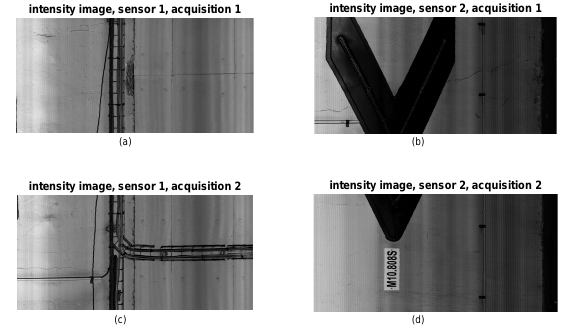
Figure 9. Images (a-b) and (c-d) represent two successive acquisitions. Image (c) must be flipped, shifted and merged with image (b) to form a continuous view of the tunnel wall.